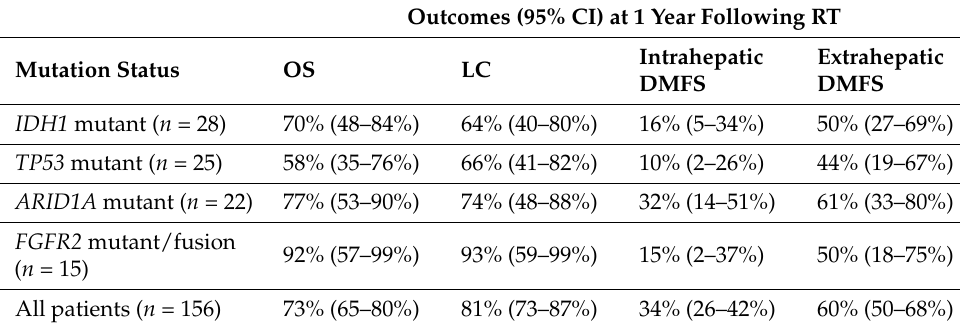
Table 2. Time-to-event outcomes of patients stratified by the most commonly mutated genes.